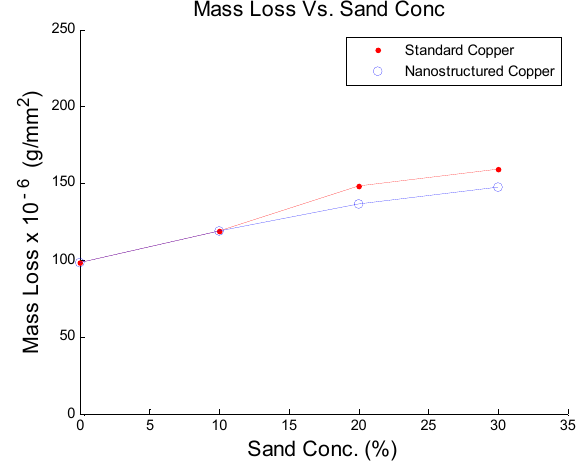
Figure 6. Mass loss versus sand concentration for both standard and nanostructure copper.